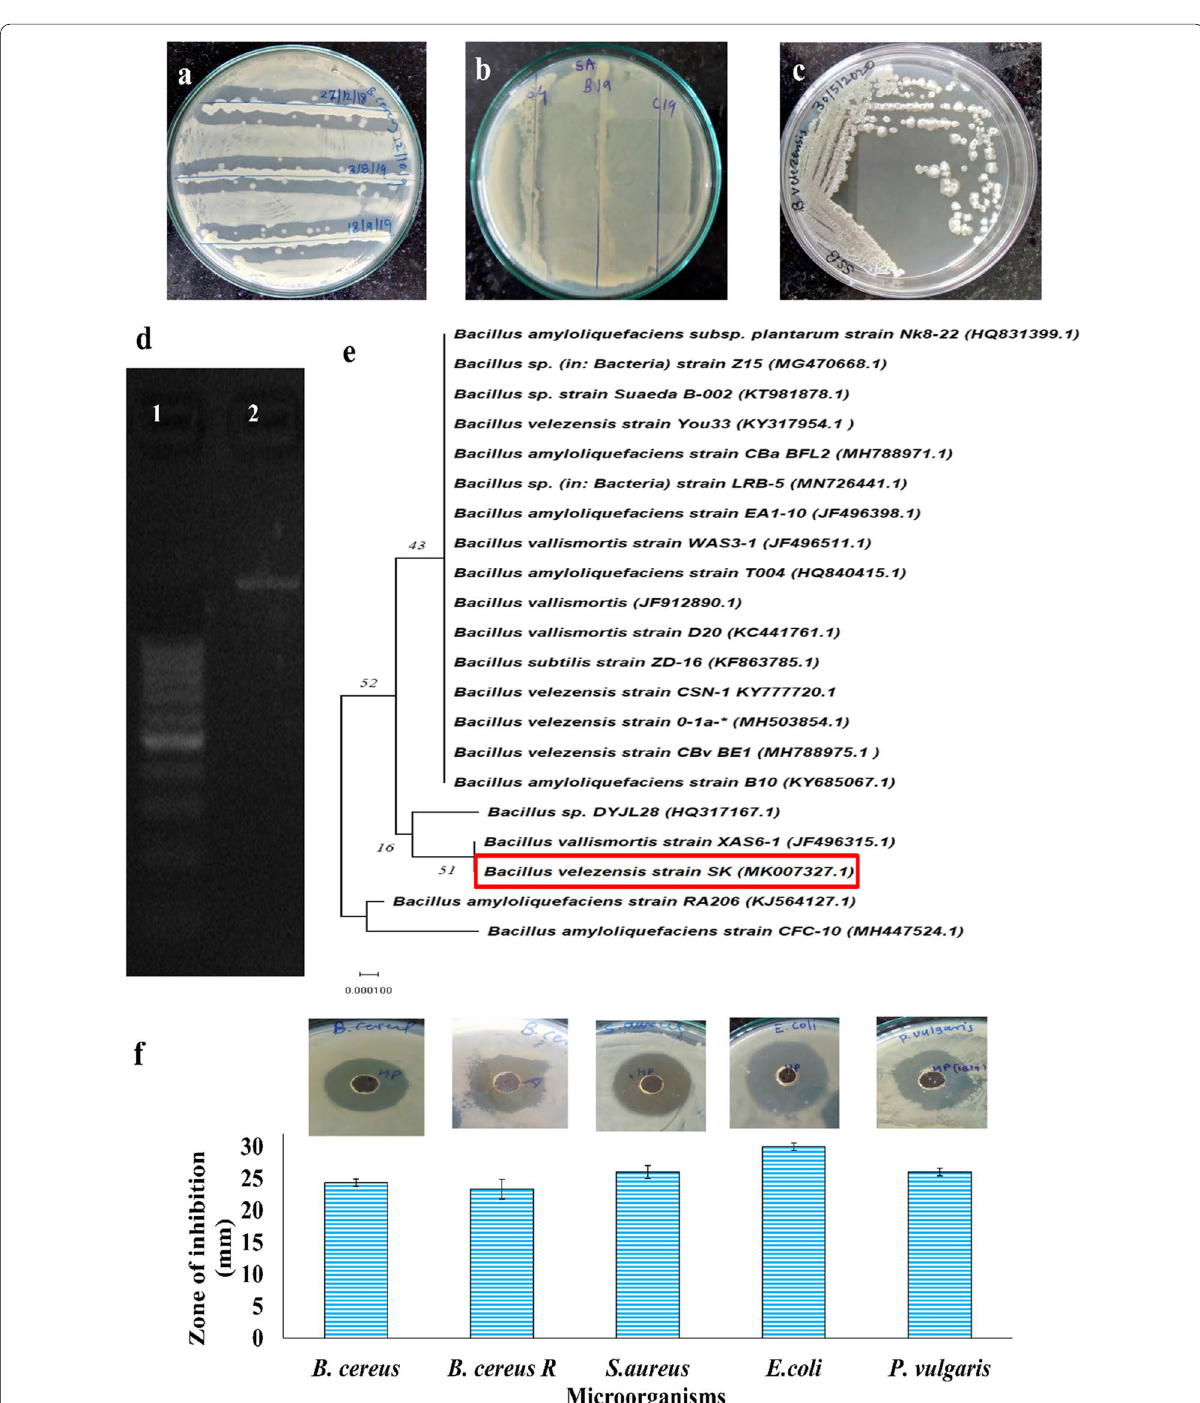
Fig. 1 Antagonistic activity of B. velezensis SK by cross streak method against a B. cereus NCIM 2703 b Staphylococcus aureus NCIM 2654, and c Colony morphology on nutrient agar d 1500 bp amplified 16 s rDNA. e Evolutionary relationship of B. velezensis SK based on 16 s rRNA and closely related species of Bacillus , phylogenetic tree was constructed by using Neighbour-Joining method by using MEGA7 software, bootstrap values on each branch point indicates 1000 pseudo replicates (scale represents 0.0001 nucleotide substitution). f Antimicrobial activity of partial purified (HP-20) lipopeptides by using agar well diffusion assay showing zone of inhibition (upper panel) in diameter in mm (lower panel) against Gram-positive and Gram-negative indicator bacteria including streptomycin resistant